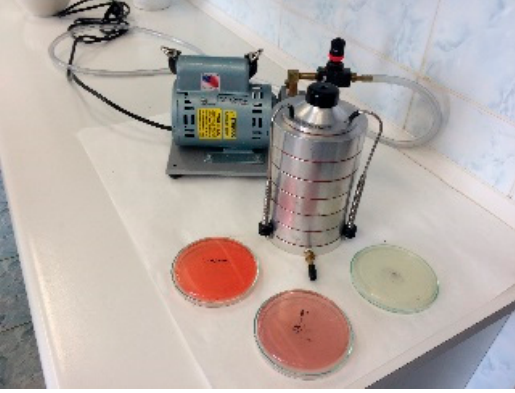
Figure 3. Photograph presenting the cascade impactor and Petri dishes.